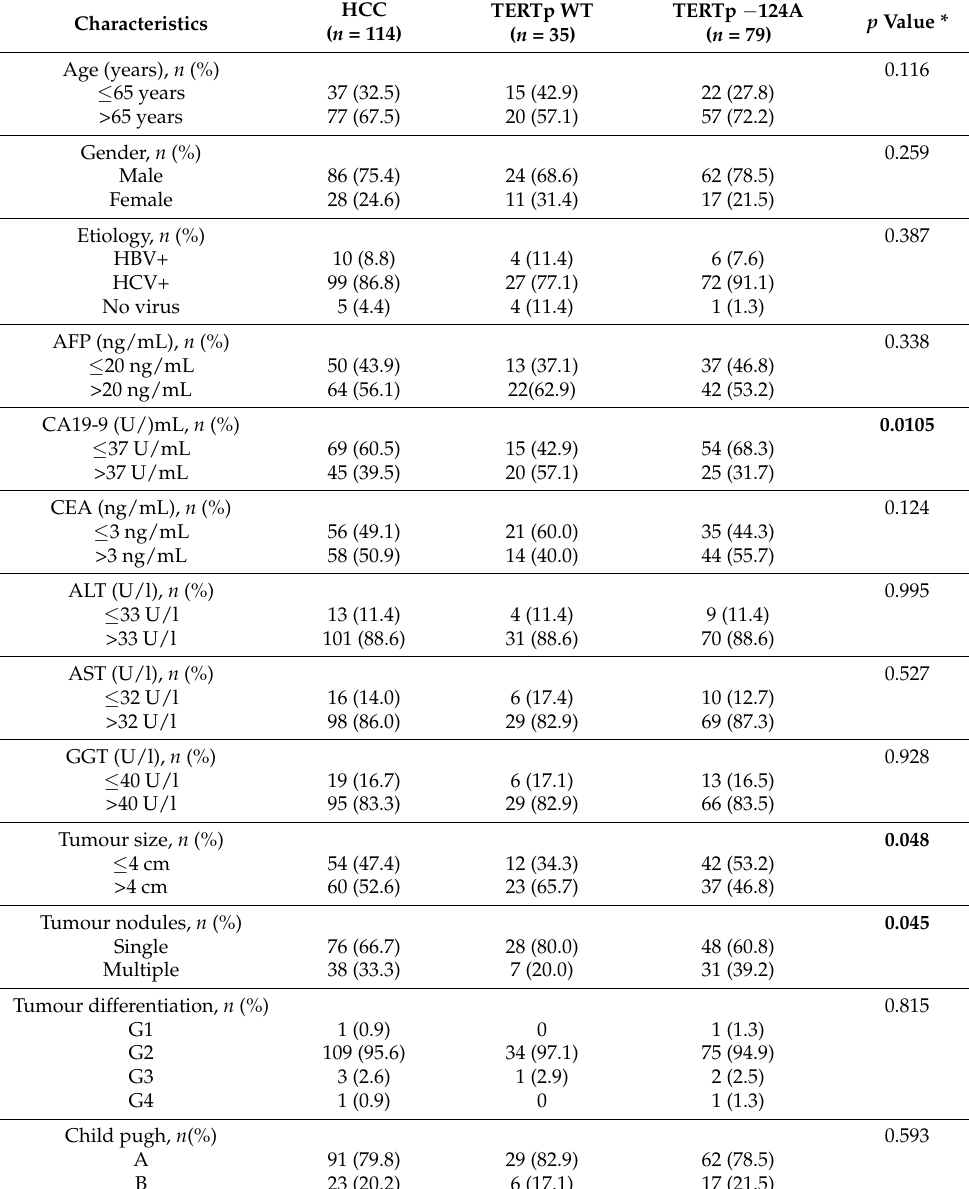
Table 3. Correlation between TERTp − 124A mutation status and clinic-pathological variables in HCC